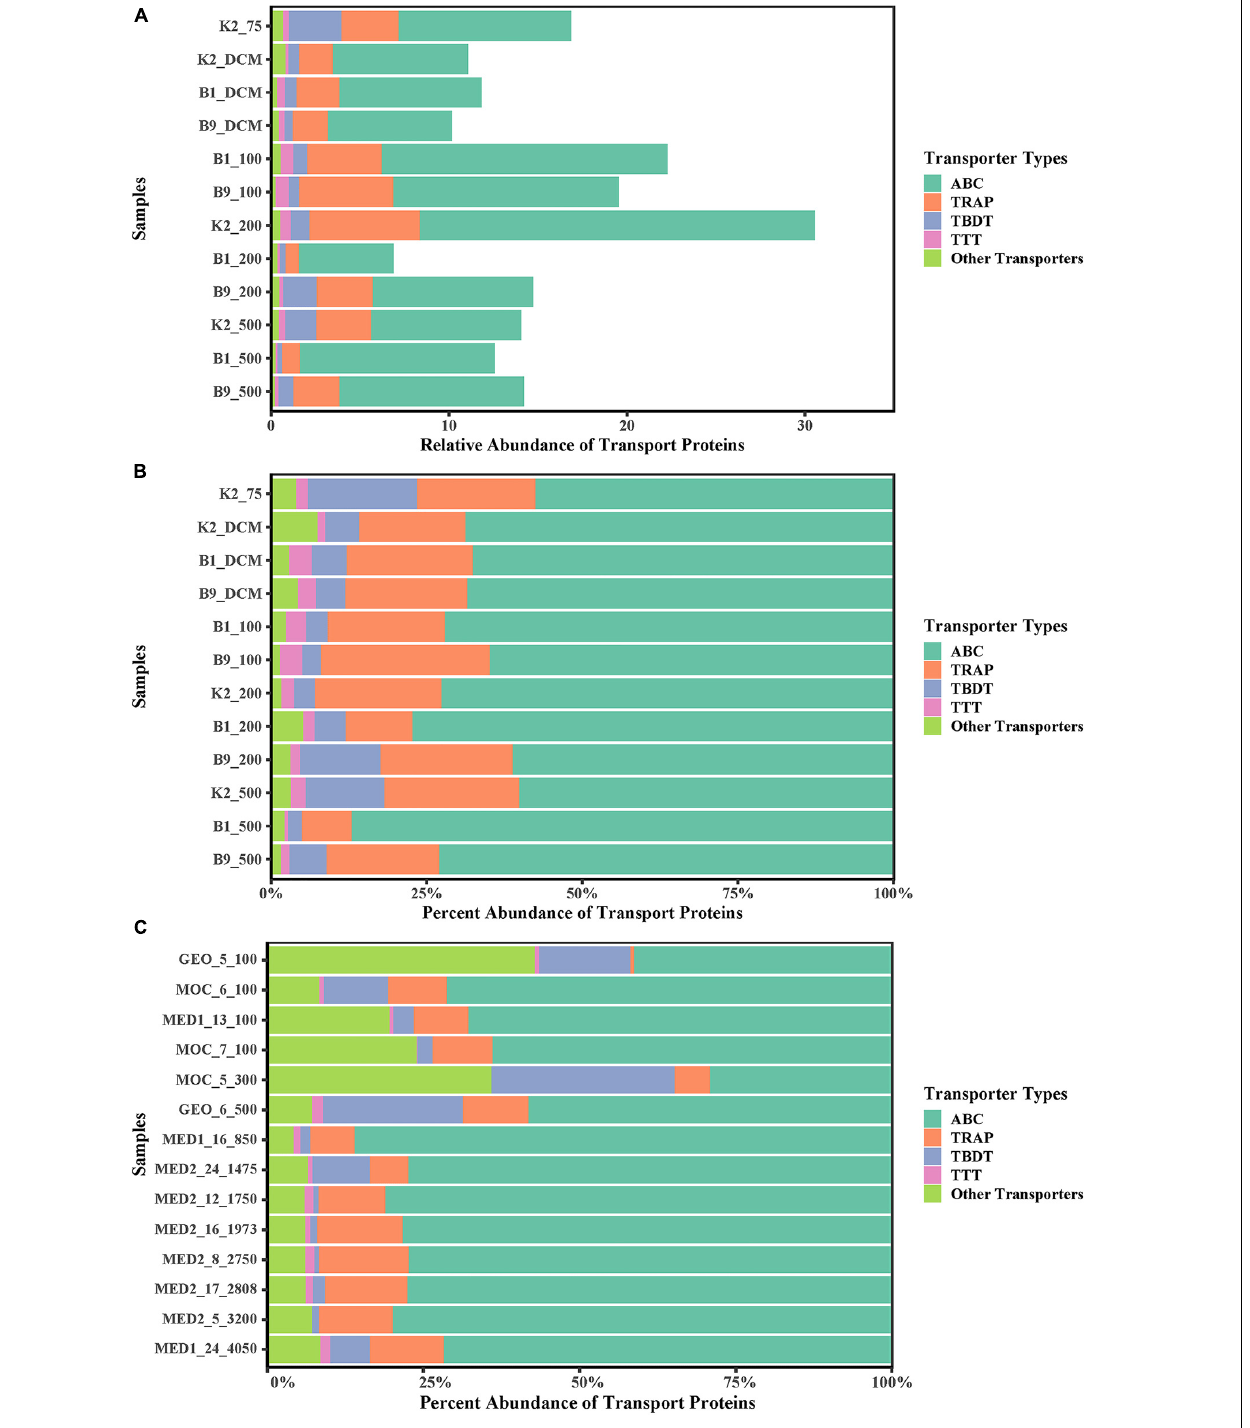
Frontiers in Microbiology |